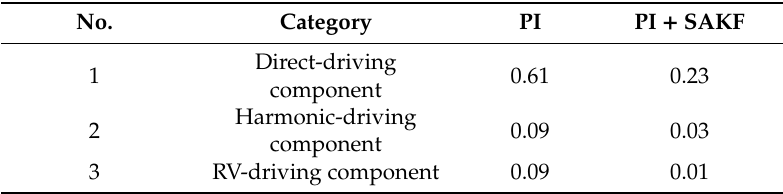
Table 3. Comparison of low-speed motion performance.